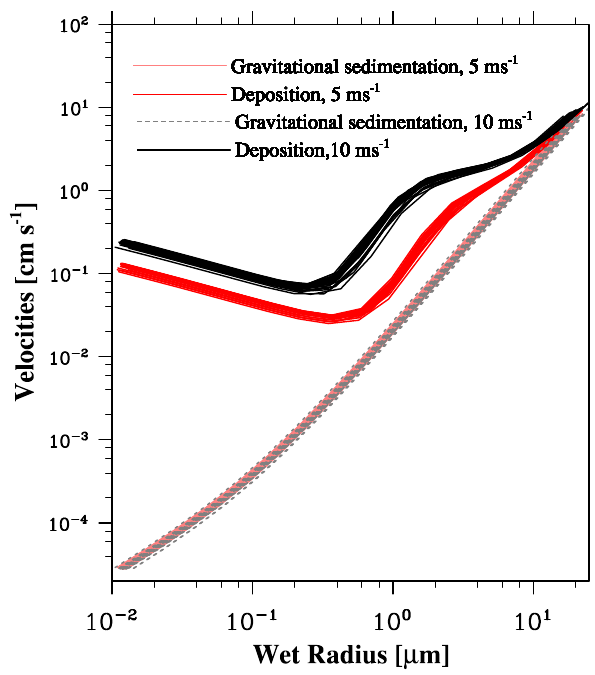
Fig. 3. Gravitational velocities and deposition velocities at the grid cells where wind speeds are 10ms − 1 and 5ms − 1 over the ocean. Variations of the curves reflect the difference in relative humidity and temperature at different